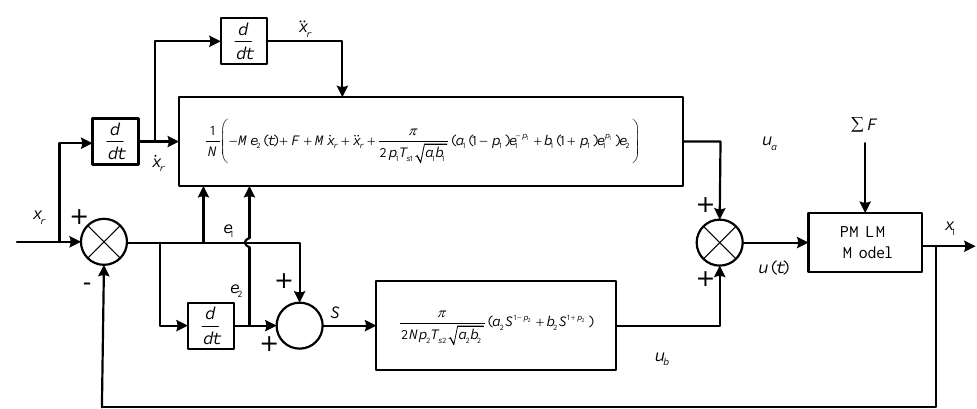
Figure 2. Structure of the proposed PreDSMC.